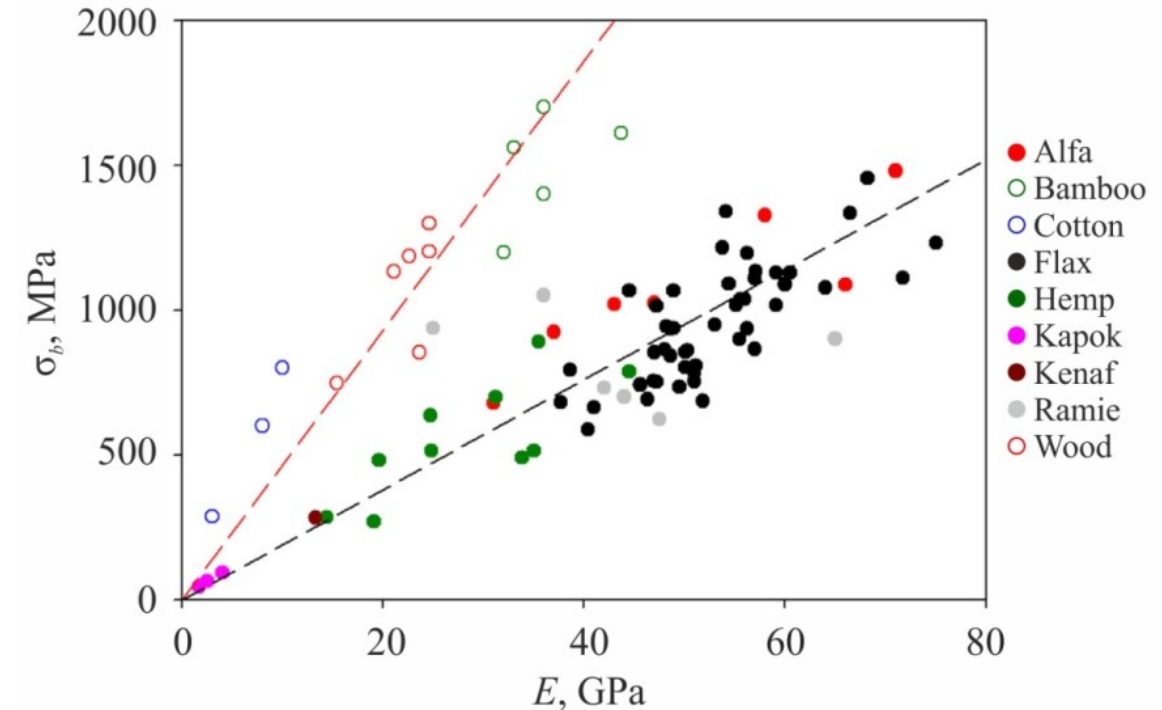
Figure 7. Dependence of cellulose fiber tensile strength upon Young modulus for various plant materials. Adapted with permission from Ref. [104]. Copyright 2018, Elsevier.